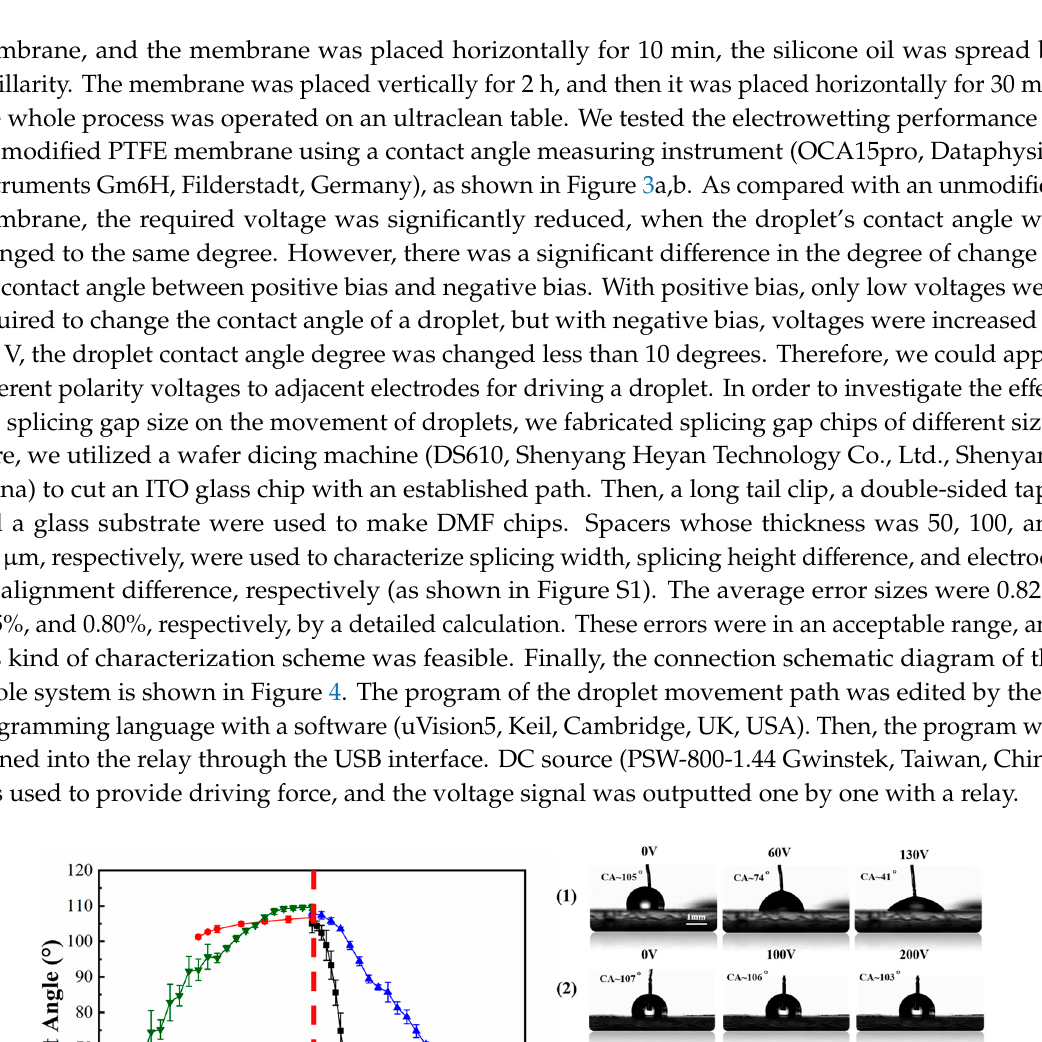
Figure 3. Electrowetting performance of a polytetrafluoroethylene (PTFE) membrane before and after modification by a 10 µ L droplet. ( a ) Curve of contact angle varying with the applied voltage; ( b ) Microscope images of contact angle measurement of droplets on a modified PTFE membrane and an unmodified PTFE membrane; ( 1 ) Microscope measurement of the contact angle of a modified PTFE membrane with di ff erent positive biases; ( 2 ) Microscope measurement of the contact angle of a modified PTFE membrane with di ff erent negative biases; ( 3 ) Microscope measurement of the contact angle of an unmodified PTFE membrane with di ff erent positive biases; ( 4 ) Microscope measurement of the contact angle of an unmodified PTFE membrane with di ff erent negative biases.